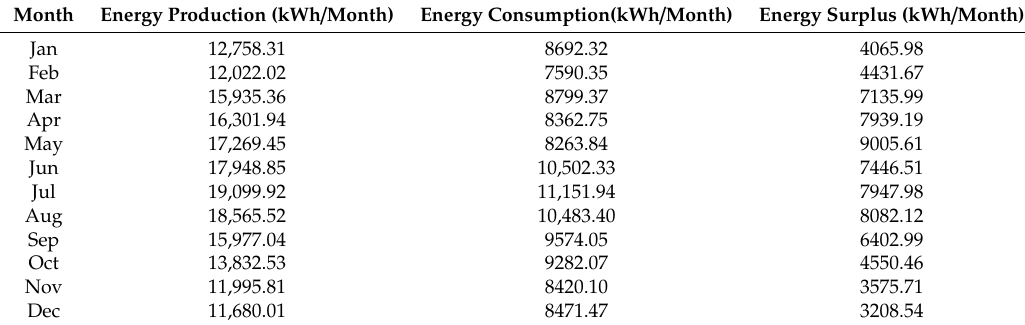
Table 5. Monthly energy surplus (kW h / month).